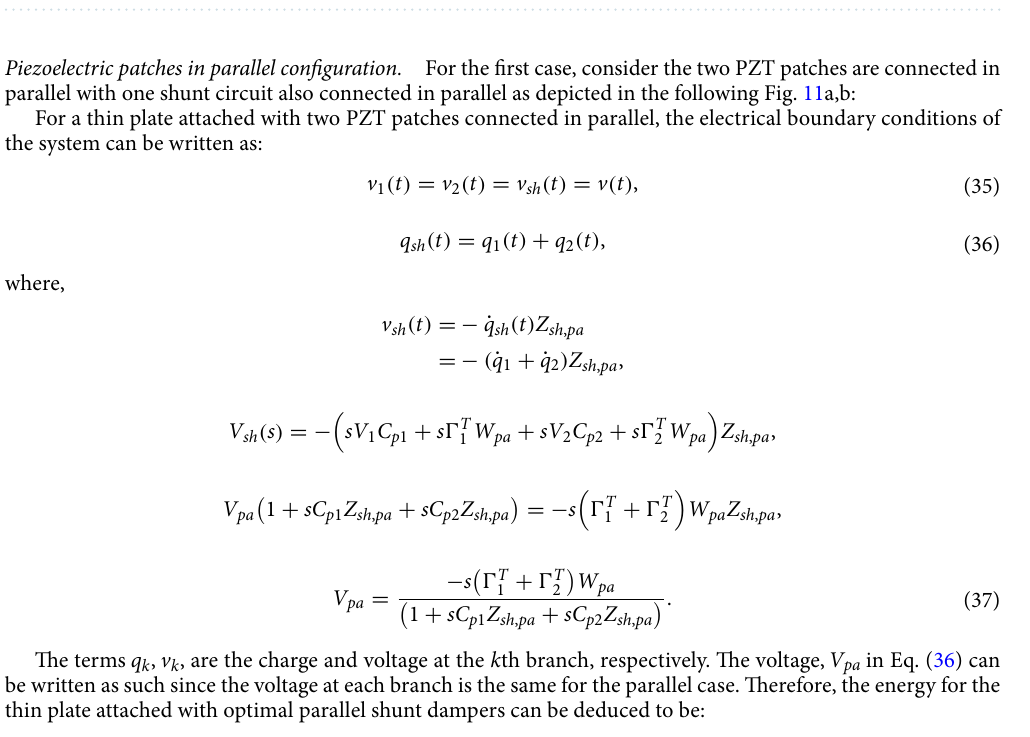
Figure 12. Equivalent electrical impedance representation of PZT shunt dampers connected in